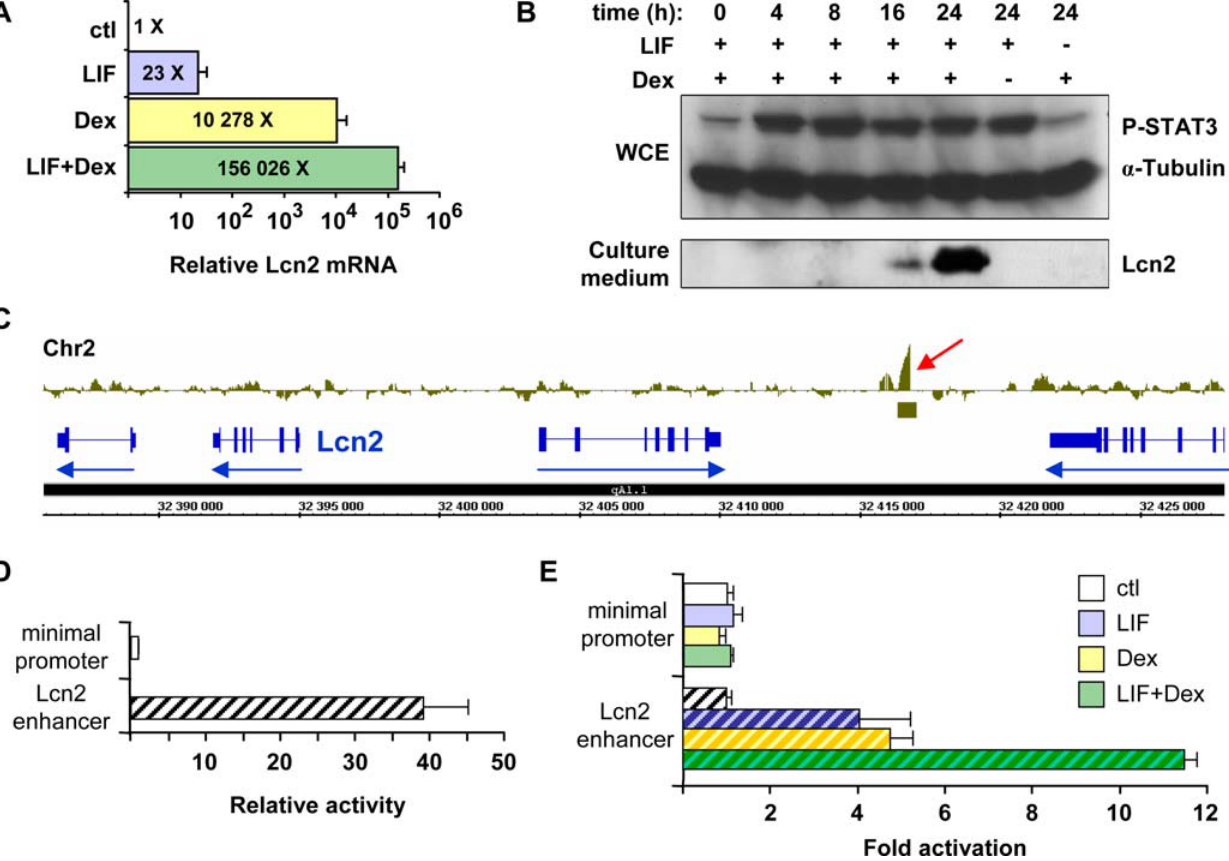
Figure 6. Highly synergistic activation of the lipocalin 2 ( Lcn2 ) gene by LIF and glucocorticoids. A) RT-QPCR analysis of Lcn2 mRNA in AtT- 20 cells treated with LIF, Dex or both. Note that the relative mRNA levels are presented on a logarithmic scale. Activation levels relative to control cells are: LIF (23-fold), Dex (10 278-fold) and LIF + Dex (156 026-fold). B) Western blot analysis of Lcn2 induction in AtT-20 cells treated for various times with LIF and Dex as indicated. P-STAT3 levels were visualized by Western blot of whole cell extracts (top panel) whereas secreted Lcn2 was revealed by analysis of culture medium. Lcn2 protein was undetectable in WCE (data not shown). C) Bar representation of STAT3 ChIP-chip data for the Lcn2 locus from the mouse whole-genome tiling array. The only significant STAT3 recruitment in the vicinity of the Lcn2 gene was observed in an intergenic region located 22 kb upstream of the Lcn2 gene (red arrow). D) The STAT3 binding region (1133 bp) of the Lcn2 locus was cloned upstream of the minimal Pomc promoter and assessed for transcriptional activity by transfection into AtT-20 cells. E) The same reporters were assessed for responsiveness to LIF, Dex and LIF + Dex, as indicated. Only Lcn2 enhancer-containing reporter exhibited hormone responsiveness. Data are presented as means 6 s.e.m. of three experiments, each performed in